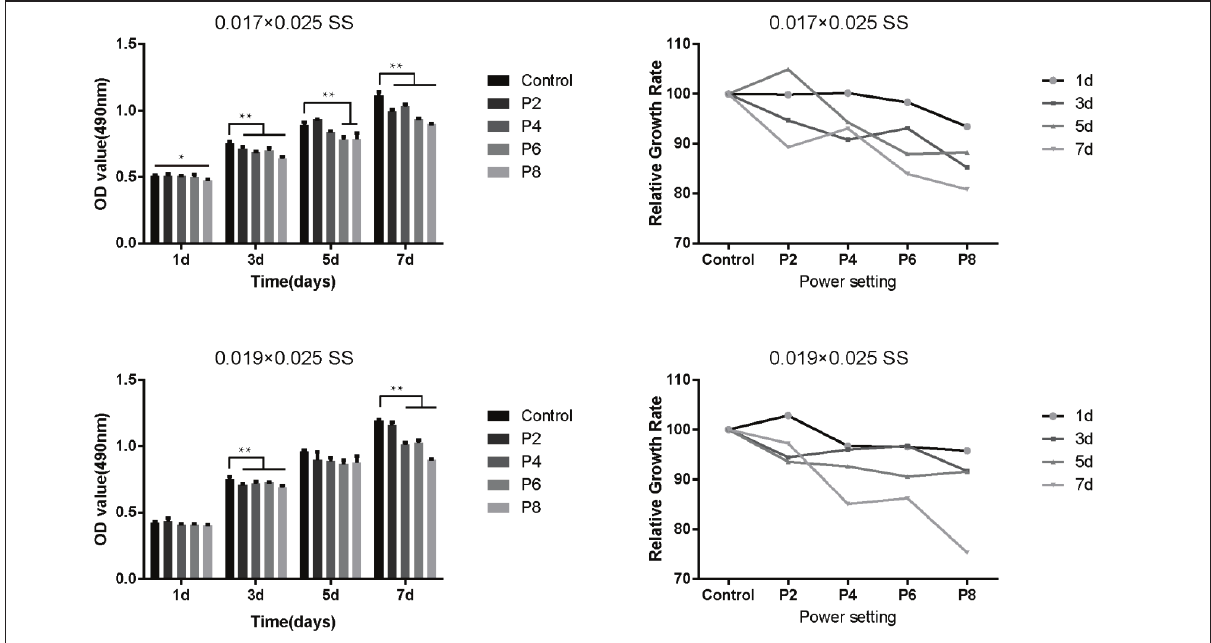
Fig. 3. Figure 3. The effect of heat-treated SS arch wire extracts on the proliferation and RGR of human gingival fibroblasts. MTT assays show the effect of heat- treated SS arch wires on the proliferation of human gingival fibroblasts on days 1, 3, 5 and 7. Cells cultured with the unheated SS arch wire extract served as the control group. * p < 0.05 and ** p < 0.01.